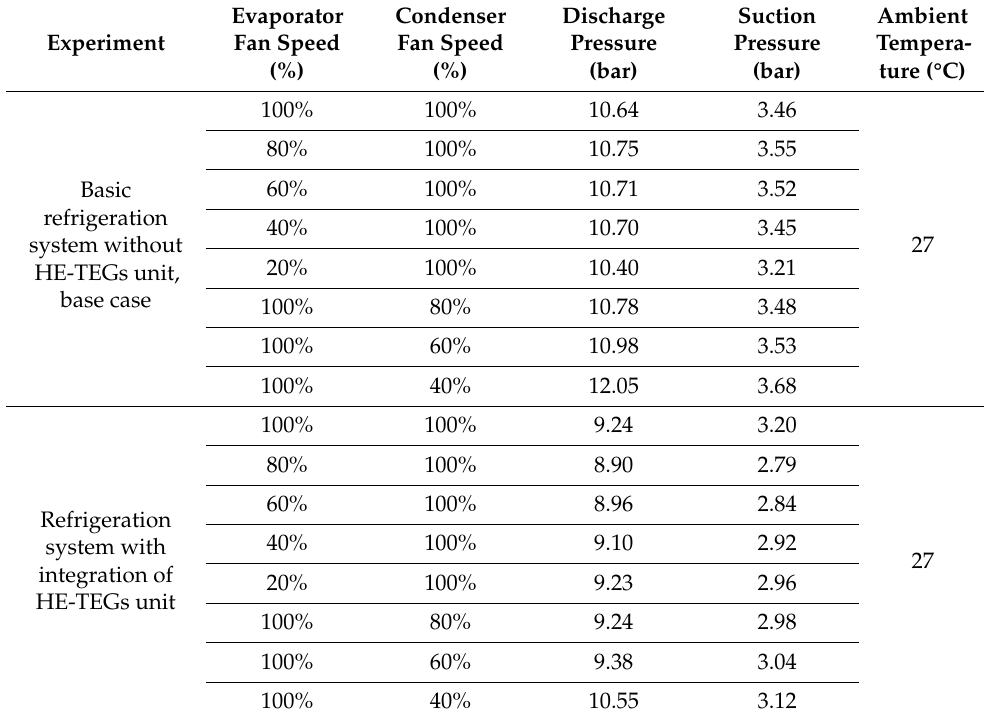
Table 2. The system power consumption during the experiments ranges from 340 to 435 W. Table 2. Summary of experiments and operating